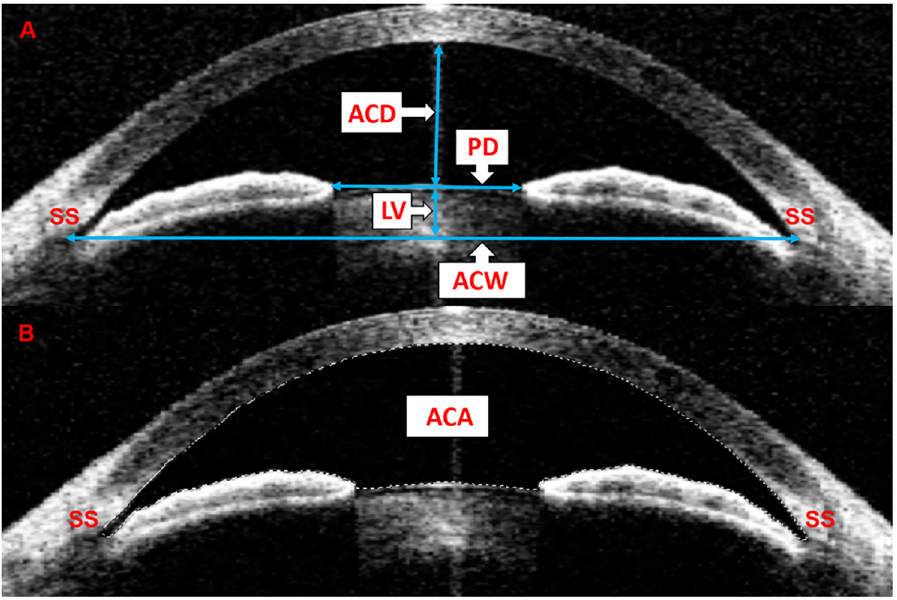
Fig 1. Determinations of ACD, ACW, ACA, PD and LV by AS-OCT. A: Anterior chamberdepth (ACD) was definedas the axial distancefrom the corneal endothelium to the anterior lens surface. Anterior chamber width (ACW) was definedas the distancebetweenthe two scleral spurs. Pupil diameter(PD) was the distance betweenthe pupil edgesof the iris. Lens vault (LV) was definedas the perpendicular distancebetweenthe anterior pole of the crystalline lens and the horizontal line connectingthe two scleral spurs. B: Anterior chamberarea (ACA) was definedas the cross-sectional area of the anterior chamber borderedby the posterior surface of the cornea, the anterior surface of the iris and the anterior surface of the lens within the pupil.